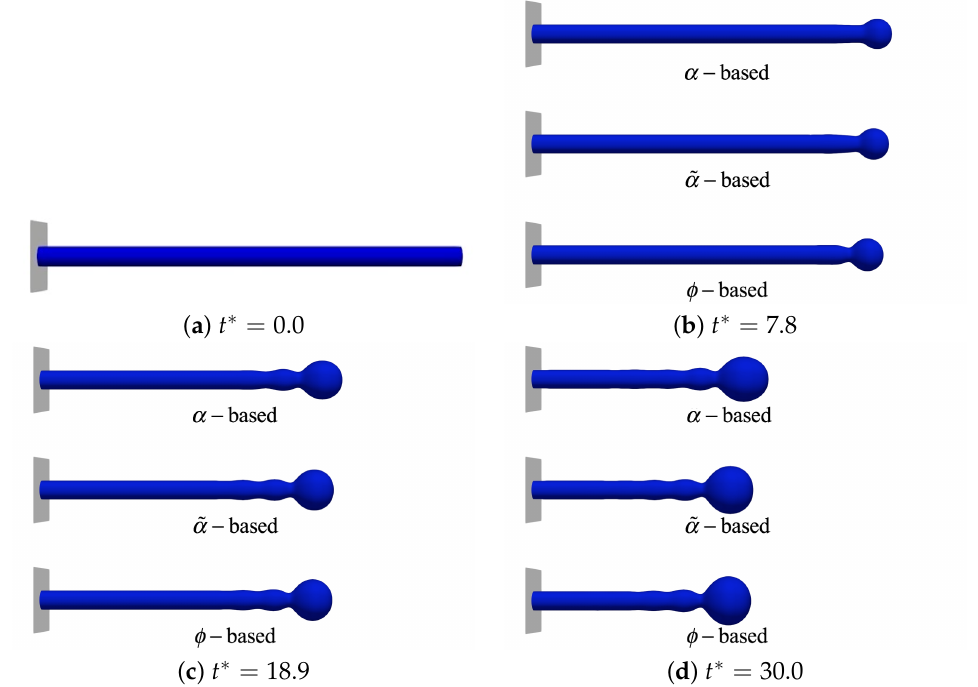
Figure 11. The evolution of the retracting liquid column corresponding to the three curvature estimation